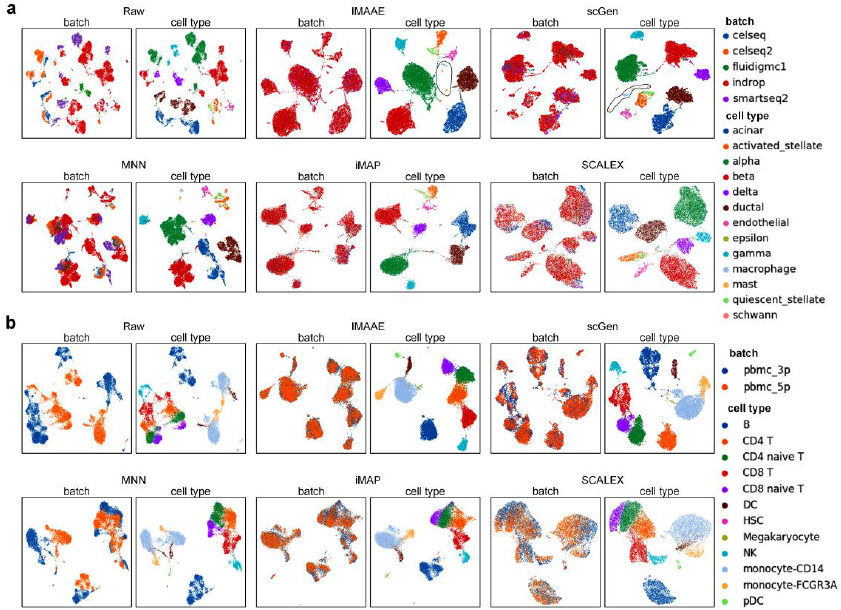
Figure 4. Qualitative evaluation of each batch correction method using UMAP visualization on ( a ) the Pancreas dataset and ( b ) the PBMC dataset. Each method contains two UMAP plots. On the left, coloring by batch type, and on the right, coloring by cell type. Table 1. Quantitative assessment of batch effect correction methods using ASW, ARI, NMI, and cor- responding F1 scores. Data